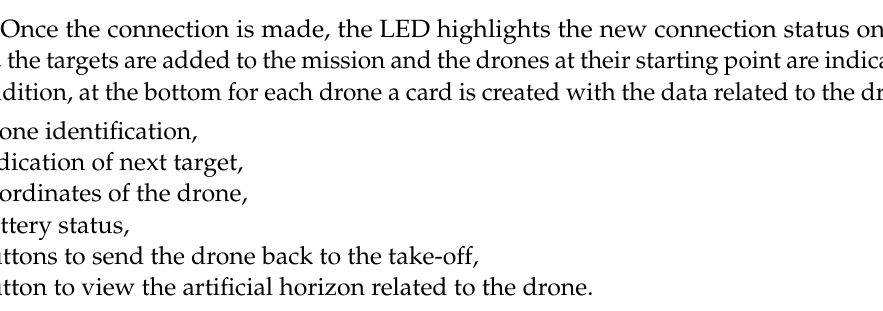
Figure 1. The GCS interface before establishing the connection.